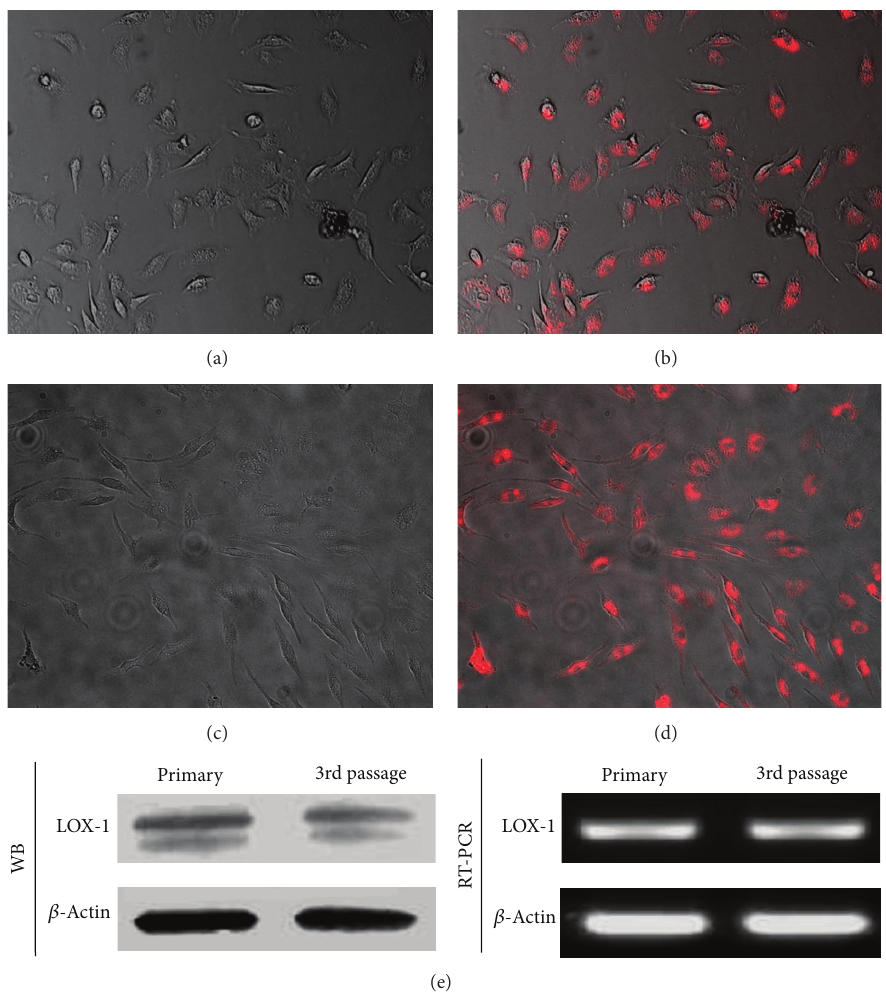
Figure 1: Uptake of Dil-ox-LDL and LOX-1 expression in bmMSCs. (a) Morphology of primary bmMSCs; (b) Dil-ox-LDL uptake in primary bmMSCs;(c)Morphologyofthe3rd-passagebmMSCs;(d)Dil-ox-LDLuptakeinthe3rdpassagebmMSCs;(e)RT-PCRandWestern-blotting assays show LOX-1 expression in the primary and the 3rd-passage